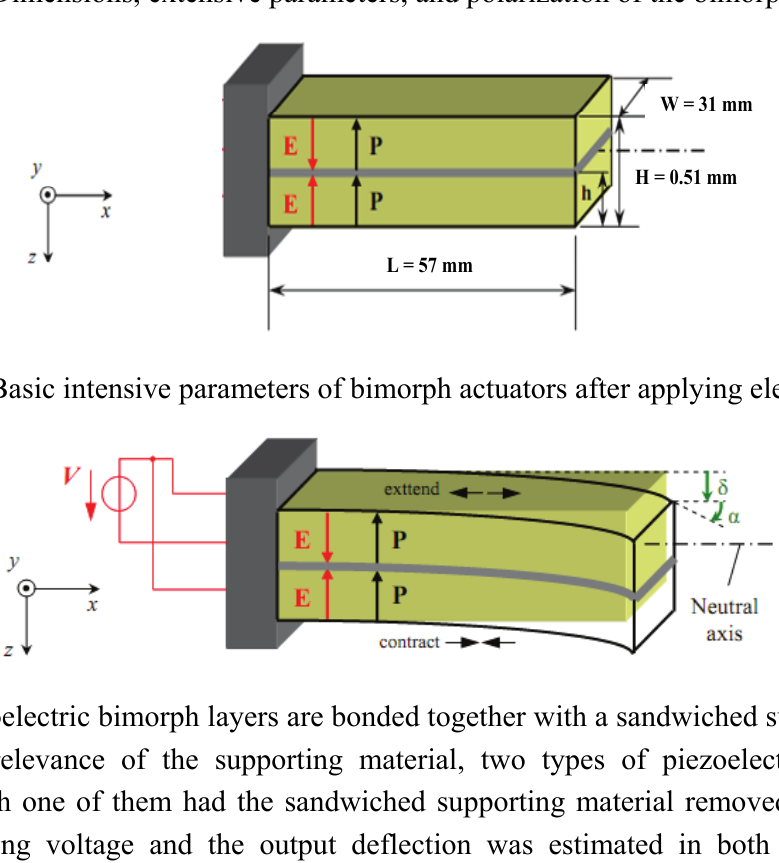
Figure 1. Dimensions, extensive parameters, and polarization of the bimorph actuator.